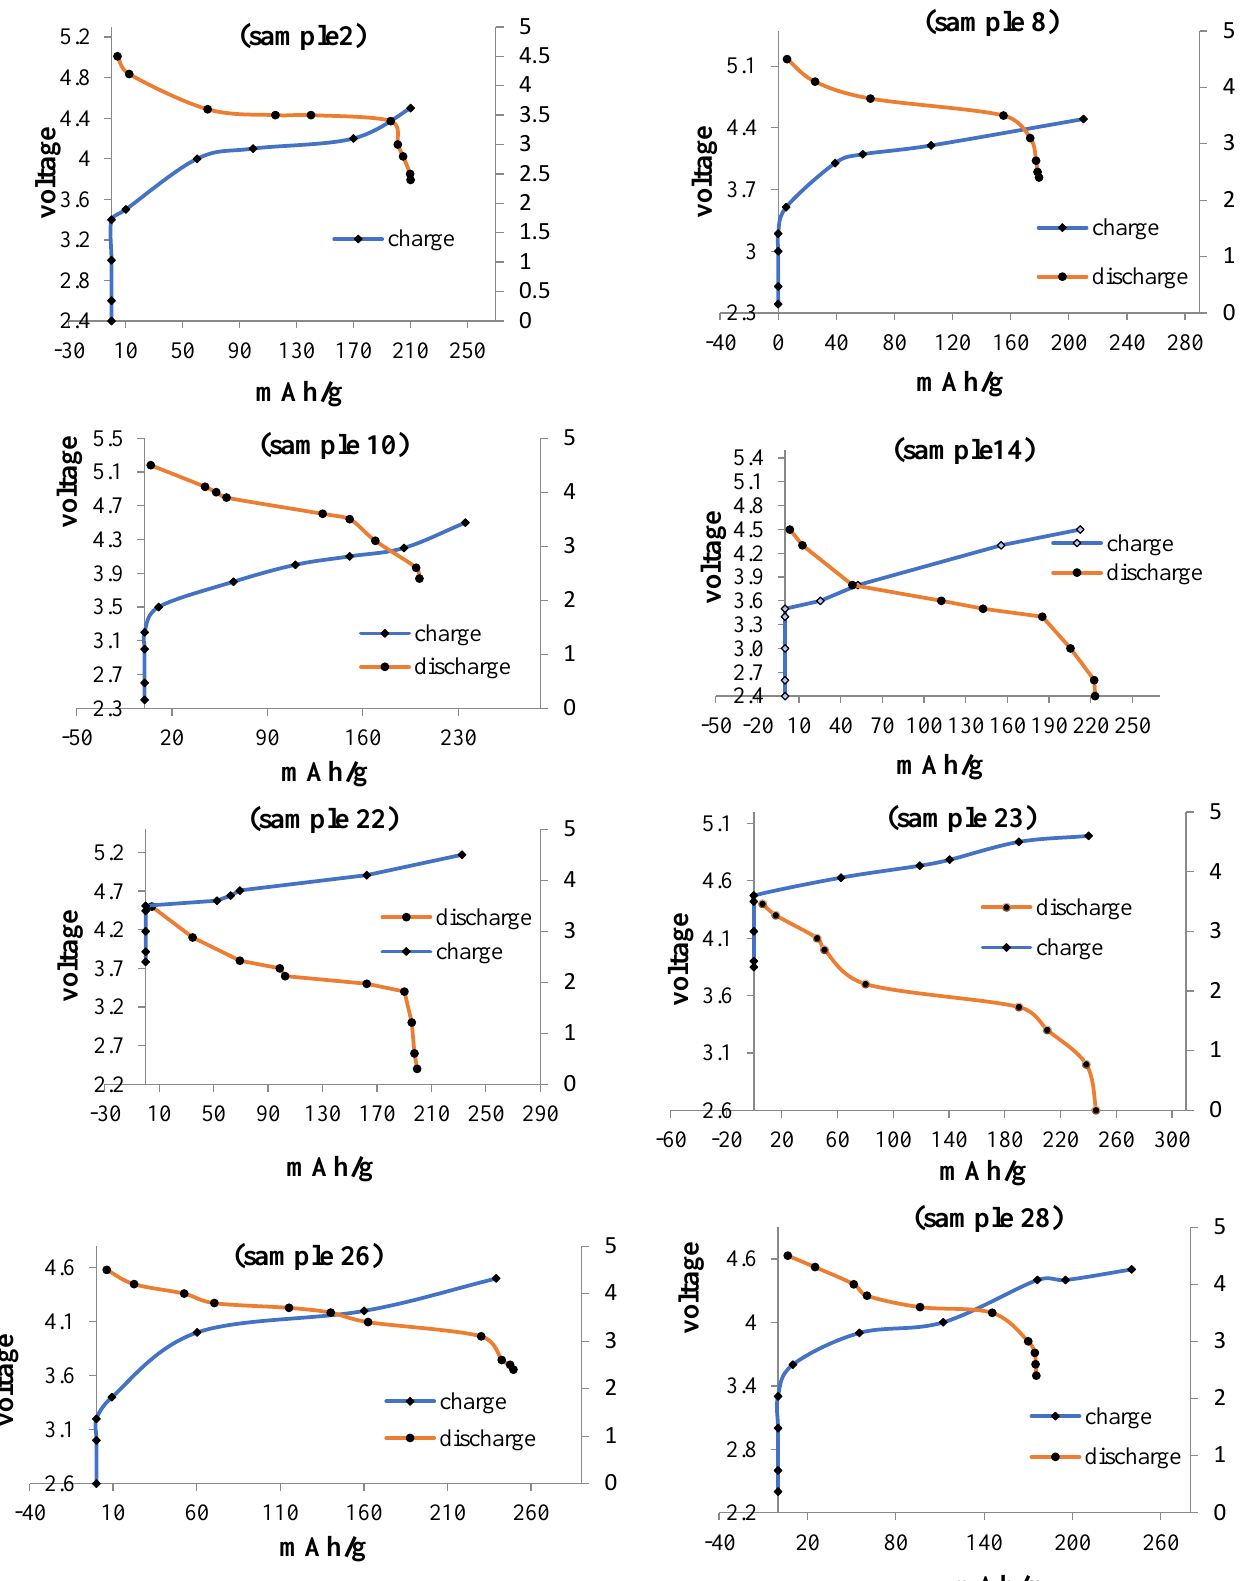
Figure 10. Charge and discharge diagrams of various samples.